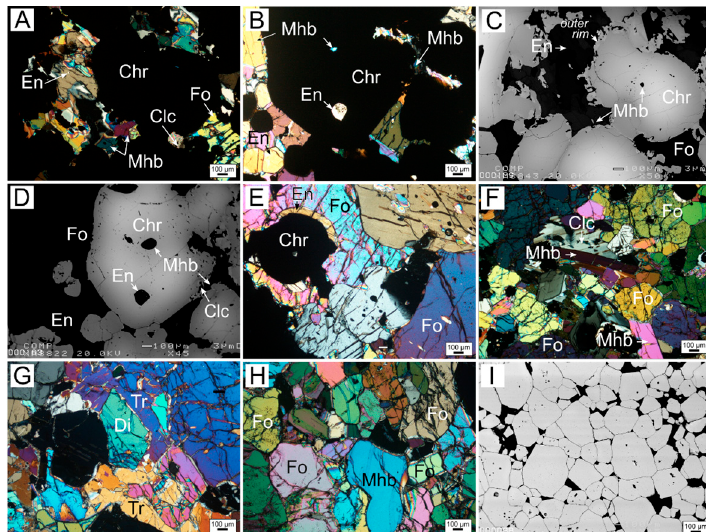
Figure 2. ( A , B ) Photomicrographs of samples with zoned chromites (Chr) showing interstitial silicate minerals that include enstatite (En), magnesiohornblende (Mhb), forsterite (Fo), and clinochlore (Clc); ( C , D ) Backscattered electron (BSE) images of the zoned chromites showing a gradual change from bright cores to dark rims. Outer rims occur as irregular overgrowths and have sharp contacts with dark rims; ( E , F ) Photomicrographs of the peridotite envelope ( E ) and host ( F ) of the chromitite hosting zoned chromites; ( G , H ) The peridotite host of the homogeneous chromites lacks orthopyroxenes, but contains diopside (Di) and tremolite (Tr); ( I ) BSE image of the homogenous chromite shows uniform brightness from core to rim. Geosciences 2018 , 8 , x FOR PEER REVIEW